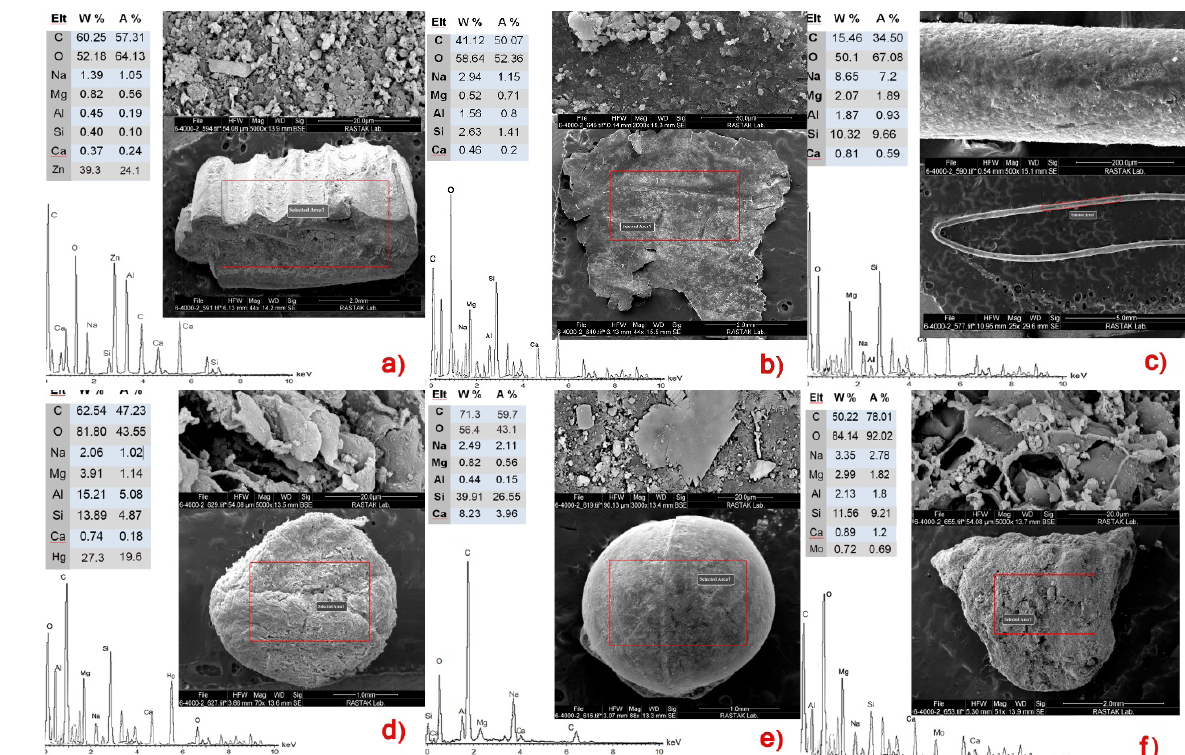
Figure 5. SEM/EDS images and composition of the different MPs and MRs shapes. (A) Fragmented MP; (B) Film MP; (C) Fiber MP; (D) Foam MP; (E) Sphere MP; (F) Fragmented